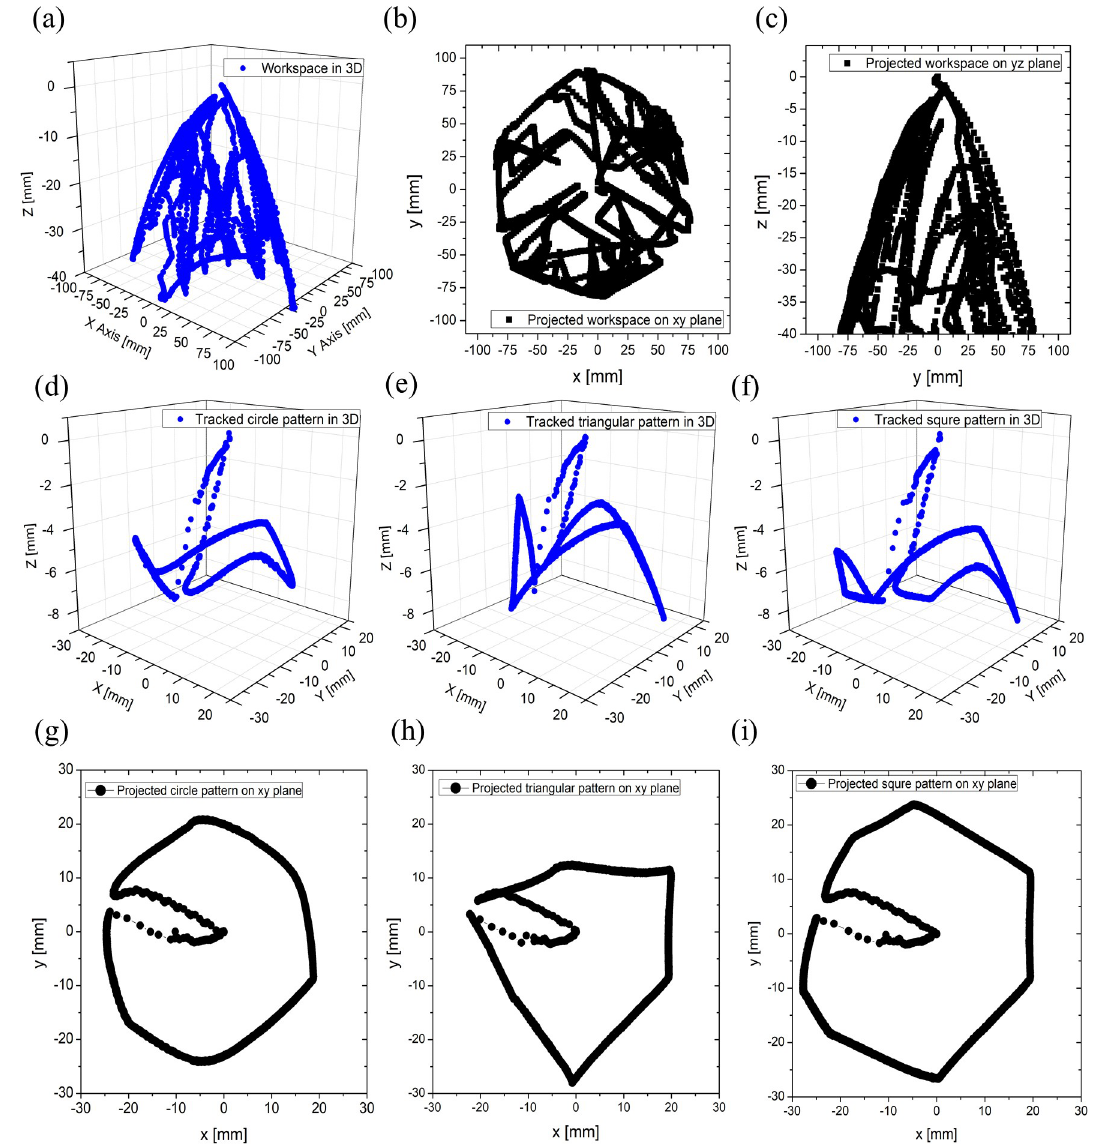
Fig 10. Results of 3DoFs Stewart platform performance: (a) workspace by joy stick in 3D; (c) workspace in yz plane; (c) workspace in xy plane; (d) tracked travel of circle drawing in 3D; (e) tracked travel of triangle drawing in 3D; (f) tracked travel of rectangle drawing in 3D; (g) tracked travel of circle drawing in 2D; (h) tracked travel of triangle drawing in 2D; (i) tracked travel of rectangle drawing in 2D.